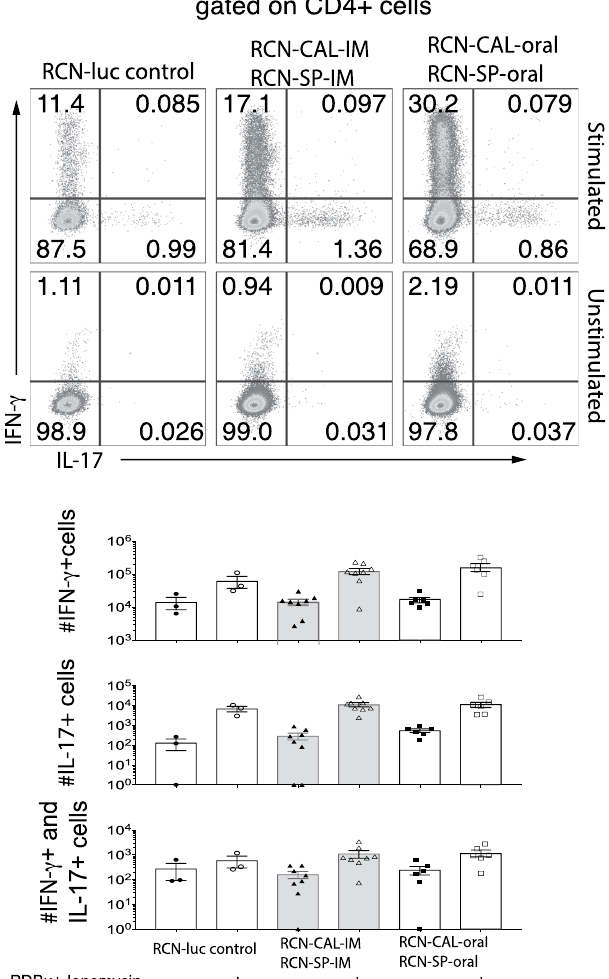
Figure 5. Cytokine expression by bat CD4 + T cells measured by Flow-FISH in vaccinated Myotis lucifugus that survived challenge with Pseudogymnoascus destructans (Pd) . Bats had been vaccinated with raccoon poxviruses (RCN) expressing calnexin and serine protease (RCN-CAL/RCN-SP) via intramuscular (IM; n = 8) or oral (n = 7) administration, or sham vaccinated with RCN expressing luciferase (RCN- luc ; n = 3). Bat splenocytes were stimulated with PDBu and ionomycin for 2 hours for RNA detection by Flow-FISH. Dot plots and histograms represent concatenates and averages of three to eight bats per